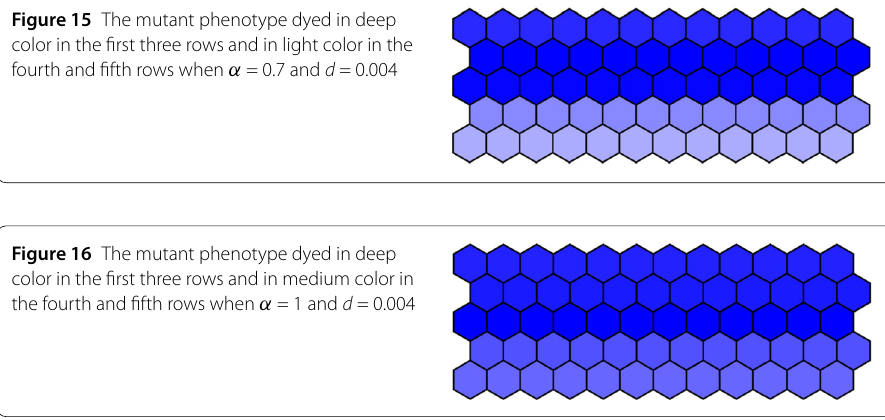
Figure 15 The mutant phenotype dyed in deep color in the first three rows and in light color in the fourth and fifth rows when α = 0.7 and d = 0.004